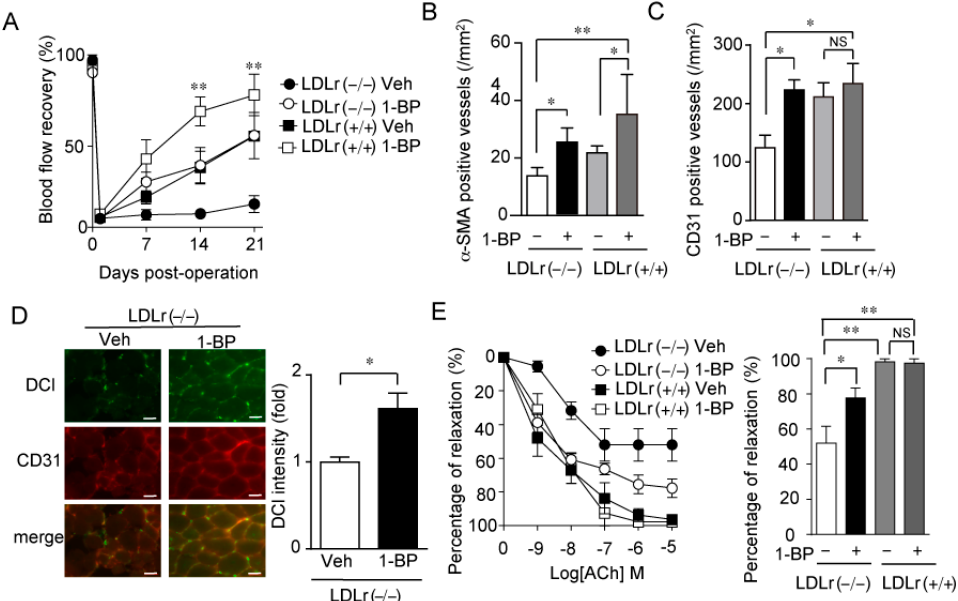
Figure 9. 1-BP improves peripheral blood circulation in mice with endothelial dysfunction. ( A ) Averaged time courses of blood flow recovery in wild type (LDLr (+/+)) and LDLr-deficient (LDLr ( − / − )) mice. Os- motic pump including 1-BP (0.1 mg/kg/day) or vehicle (Veh) was implanted 1 day before HLI (n = 4 mice per treatment and genotype). ( B , C ) Quantitative results of the number of α -SMA positive vessels ( B ) and CD31 positive vessels ( C ) at 21 days after HLI. (n = 4 mice). ( D ) Endothelium-dependent NO production detected by DCl-Da cal AM (10 nM) in CD31-positive vessels of ischemic gastrocnemii with 1-BP or Veh. Representative images (left) and quantitative result (right). Scale bars: 50 µm. ( E ) Effect of 1-BP on the endothelium-dependent relaxation of thoracic aorta. Aorta was first submaximally contracted by phe- nylephrine (10 µM) and then endothelium-dependent relaxation was induced by the indicated concen- tration of acetylcholine (ACh). Right, peak relaxation of aorta induced by 10 − 5 M ACh. Data are mean ± s.e.m. ( A , D , E ) or median with 95% CI ( B , C ). * p < 0.05, ** p < 0.01. Comparisons were made using Two- way ANOVA followed by Tukey’s multiple comparison tests ( A ), Kruskal-Wallis test ( B , C ),